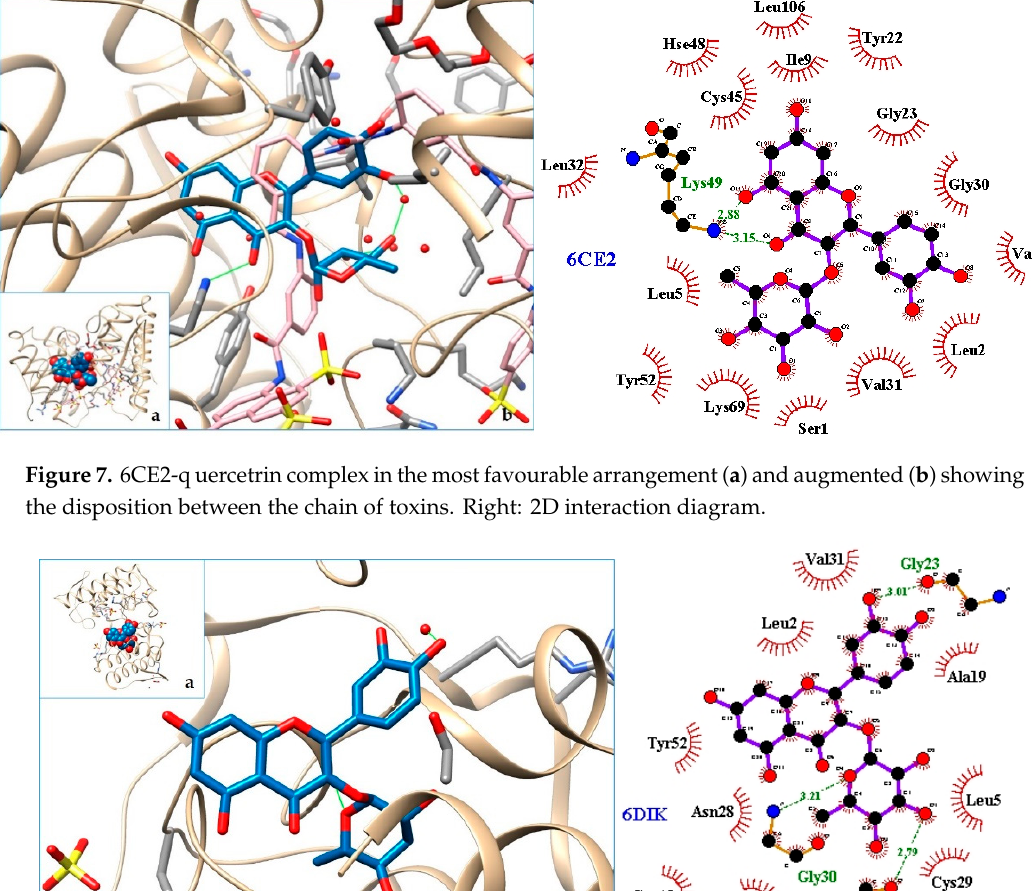
Figure 6. 3CXI-quercetrin complex in the most favourable arrangement ( a ) and augmented ( b ) showing the disposition between the chain of toxins. Right: 2D interaction diagram.